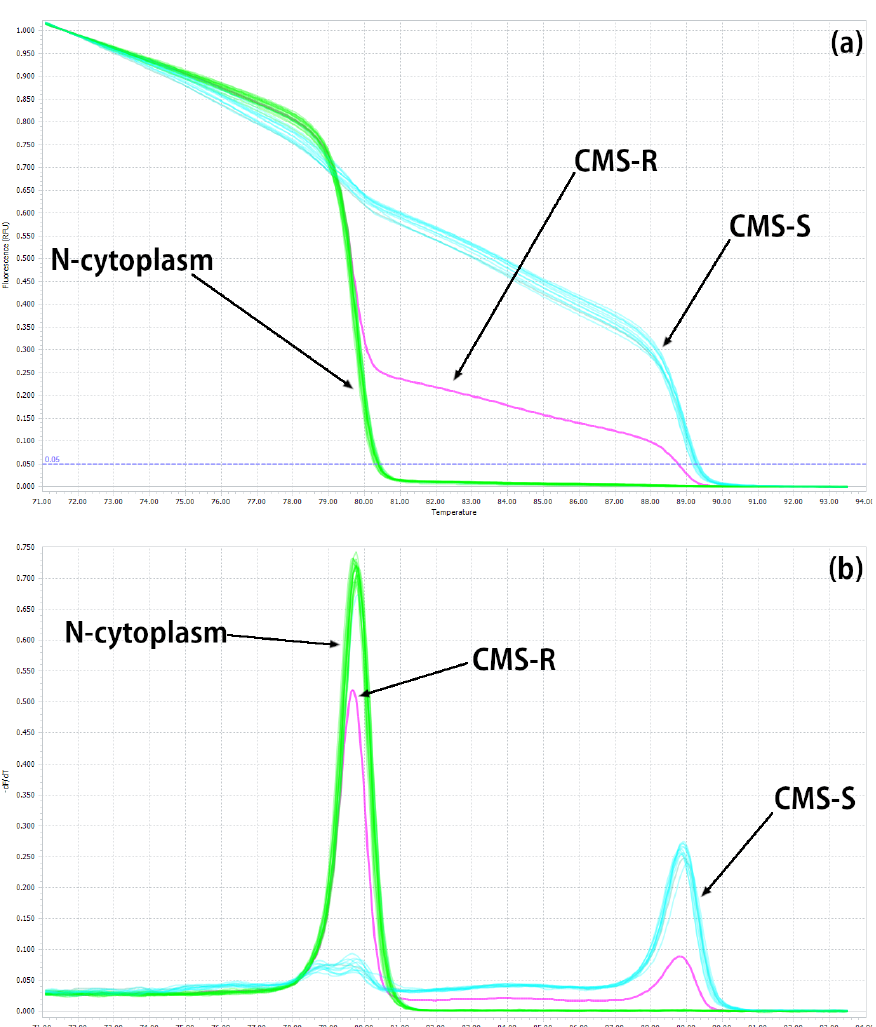
Figure 2. HRM analysis of cytoplasm type in onion using three AcM-HRM primers based on cox1 and orf725 mitochondrial genes: ( a ) normalized melting curve of amplicons and ( b ) normalized melting peaks of